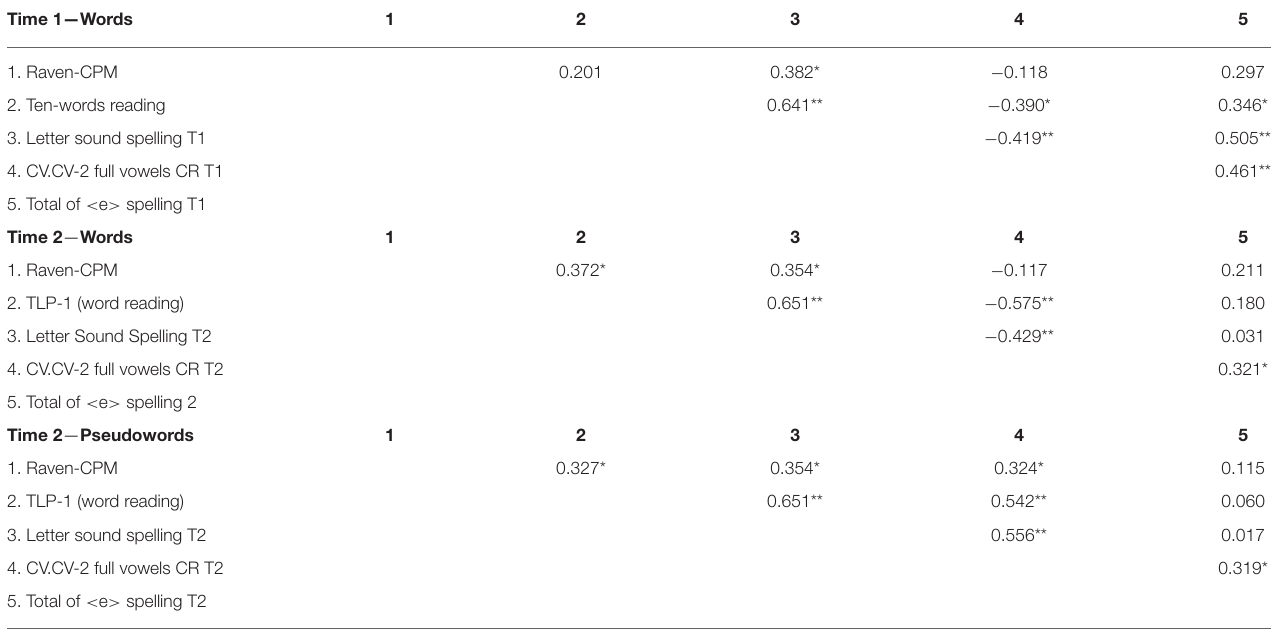
TABLE 5 | Correlations between ancillary alphabetic measures and the total amount of < e > spelling representing the schwa at T1 and at T2. Time